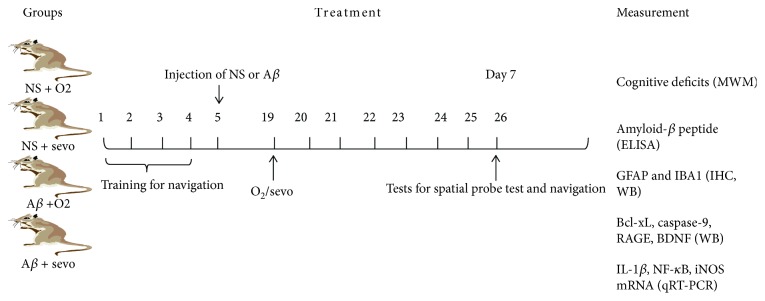
Schematic representation of study designs. Animal model of Alzheimer disease was established with injection of NS or Aβ on day 7. Those animals started to inhale 30% O2 or 2.5% sevoflurane after 14 days of the above injection.